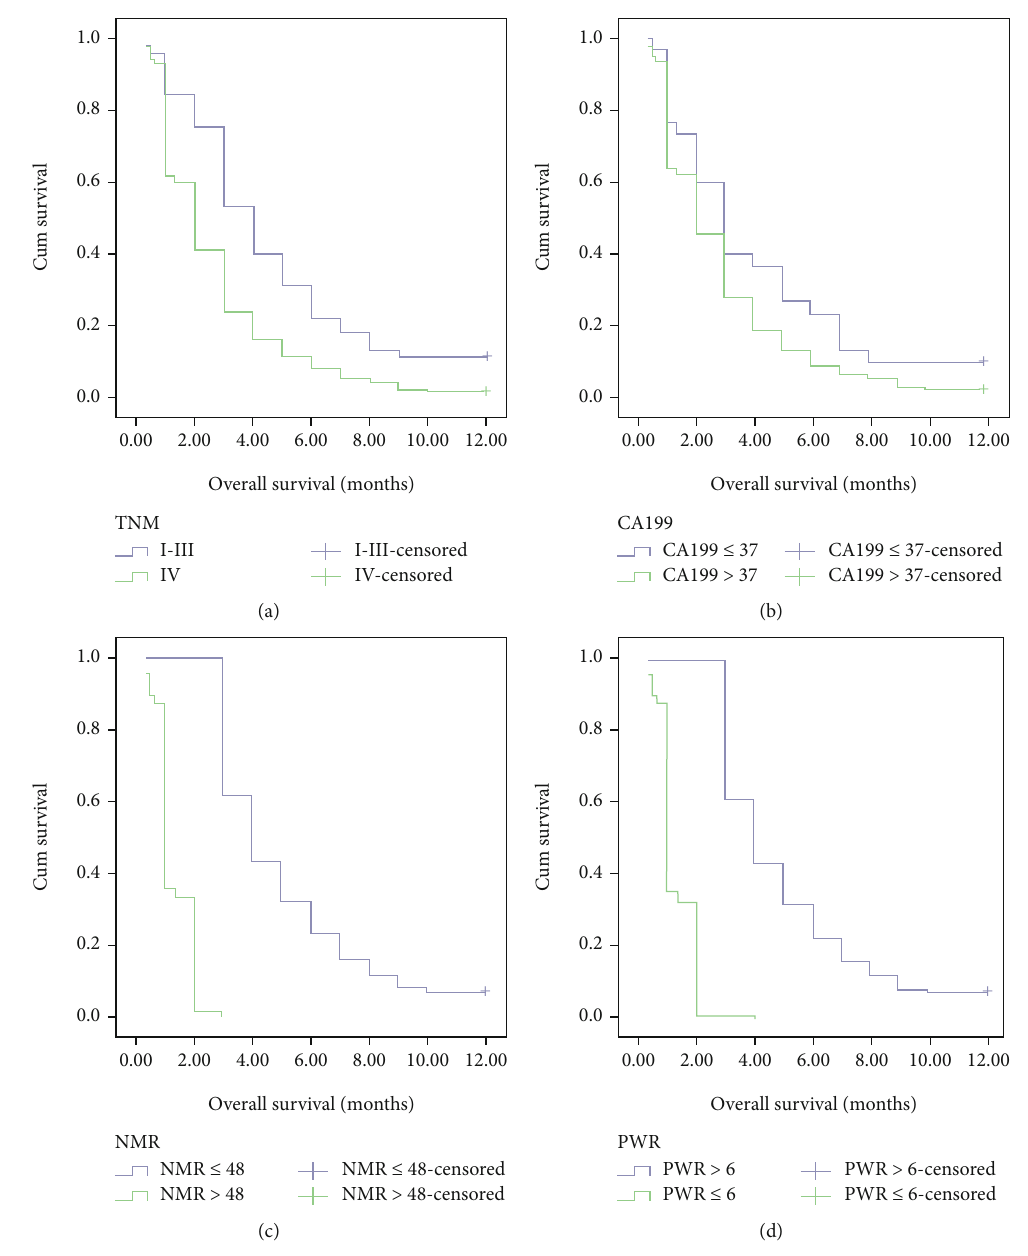
Figure 2: Kaplan-Meier curves for cumulative survival. (a) The OS of TNM I-III stages was longer than that of stages IV ( P < 0 : 001 ). (b) The OS of patients whose CA199 < 37 was longer than CA199 ≥ 37 ( P = 0 : 034 ). (c) The OS of patients with pancreatic cancer with NMR ≤ 48 is longer than that of patients with NMR > 48 ( P < 0 : 001 ). (d) The OS of patients with pancreatic cancer with PWR > 6 is longer than that of patients with PWR ≤ 6 ( P < 0 : 001 ). Table 6: Univariate Cox analysis at di ff erent variables for OS. Table 7: Multivariate Cox analysis at di ff erent variables for